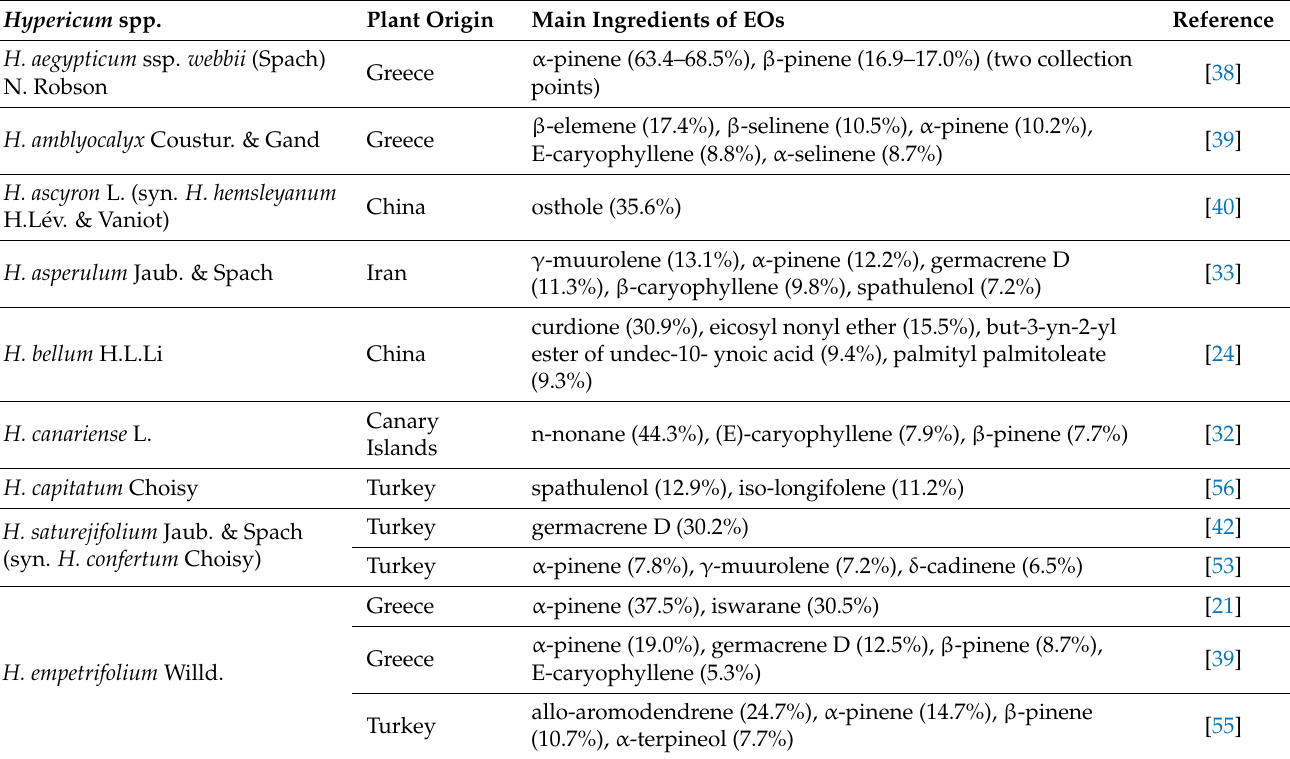
Table 1. Literature survey (2012–2022) on essential oils from Hypericum